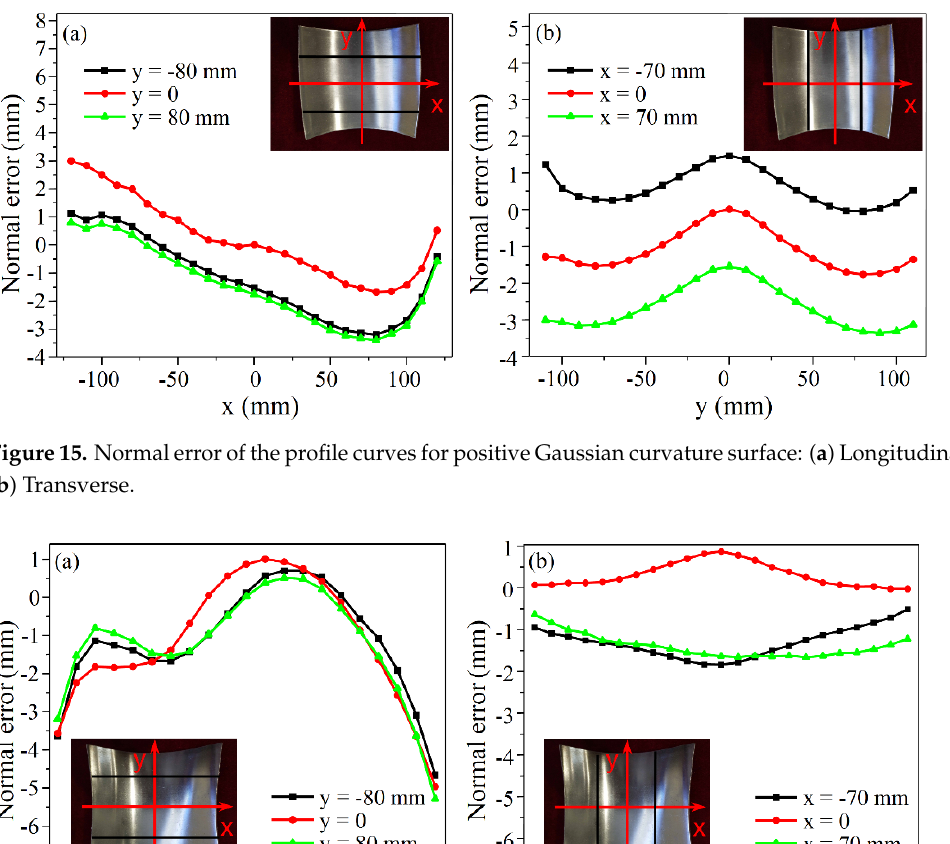
Figure 17. Comparison of the profiles of the longitudinal centerline for 08 Al sheets: ( a ) Positive Gaussian curvature sur- face; ( b ) Negative Gaussian curvature surface. 0 C Y ′ and 0 S Y ′ are the calculated radii of the longitudinal centerline of the positive and negative Gaussian curvature surfaces after correction, while 1 C Y and 1 S Y